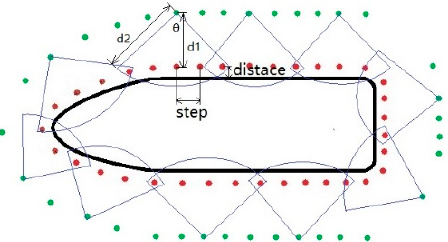
Figure 11. Schematic diagram of the tracking chassis trajectory planning.